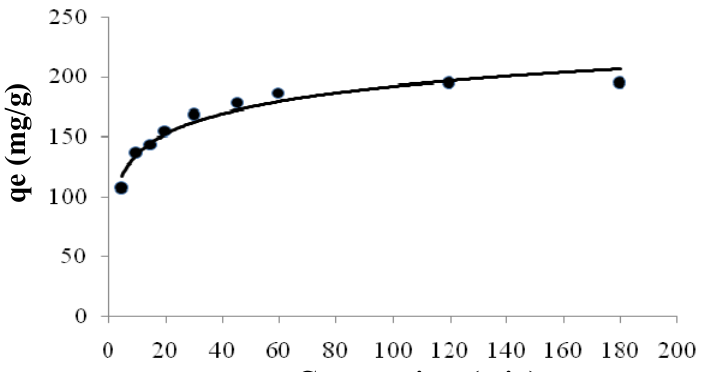
Figure 3. Effect of contact time on cadmium (II) biosorption by modified Tamrix articulata wastes at pH 4 and 30